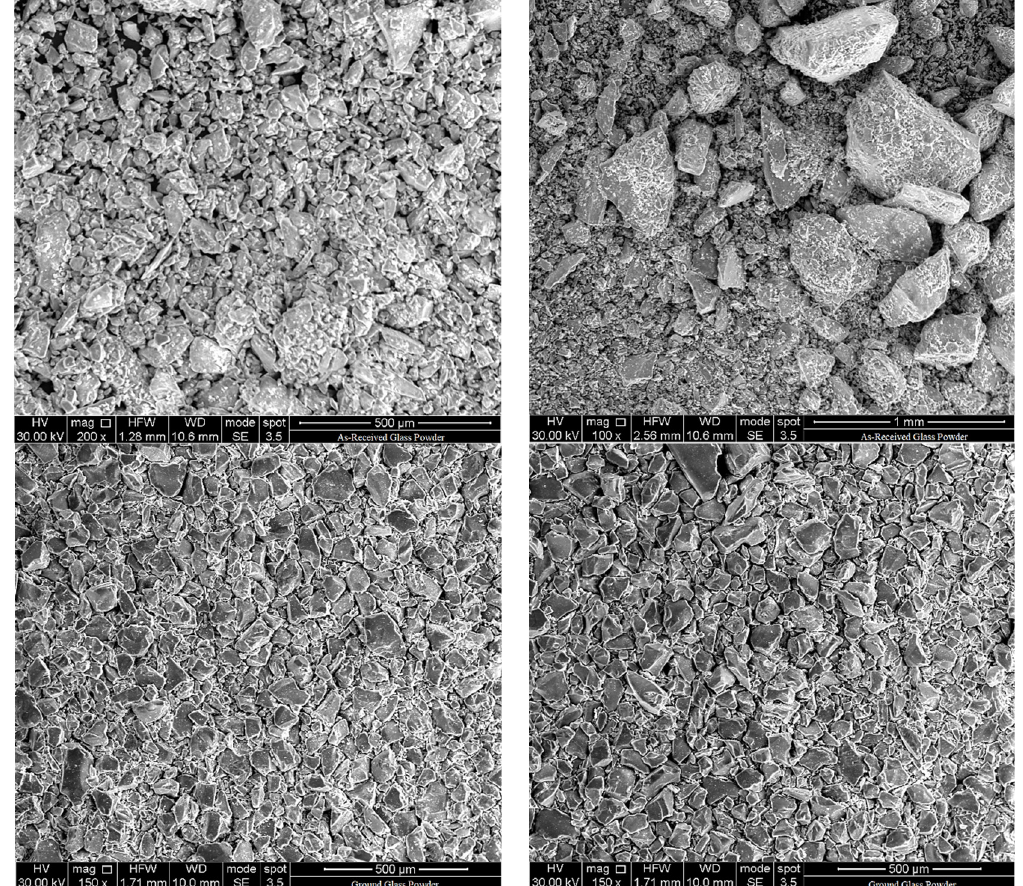
Figure 2. SEM micrographs of as-received ( above ) and ground ( below ) glass powder. The results of pozzolanic activity tests are shown in Figure 3.